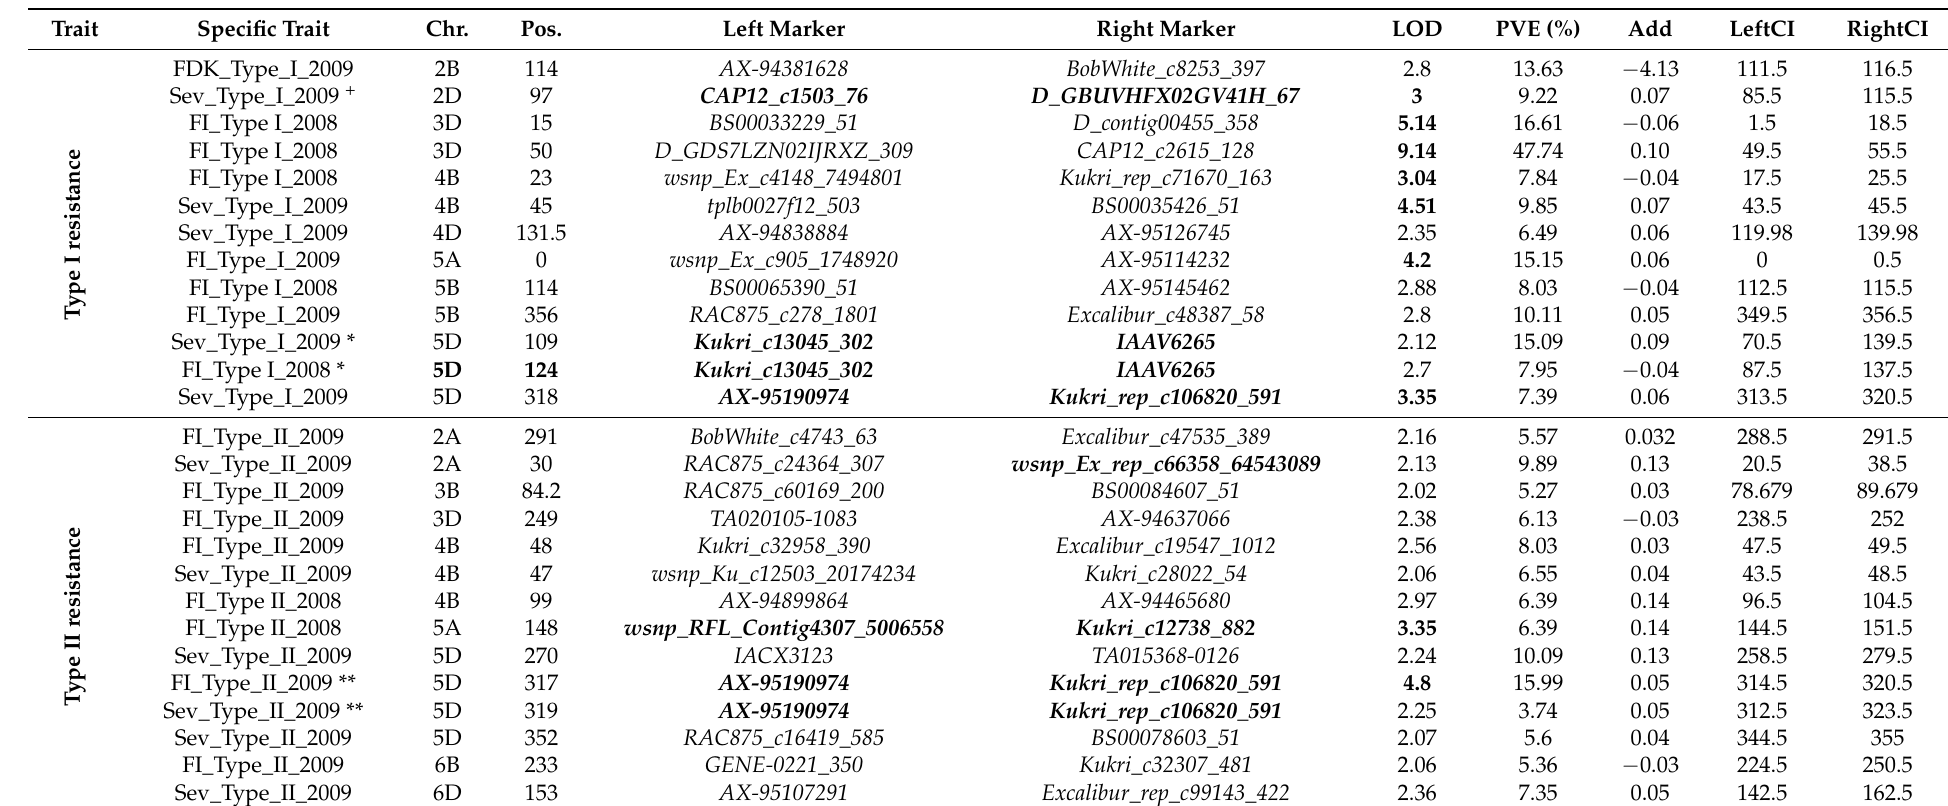
Table 2. Traits for Type I and II resistance against FHB that were significantly associated to marker loci, chromosome linked to, the additive effects, the level of significance and the variability explained, determined in ITMI/MP inoculated with F. graminearum. Severity: Sev_Type_I and Sev_Type_II; Fusarium index: FI_Type I and FI_Type II; thousand kernel weight in control (TKW_C) and for type I (TWG_Type I); Fusarium damaged kernel: FDK I; kernel weight per spike in control (KWS_C) and for Type I (KWS_Type I) and Type II (KWS_Type II). Markers involved in multiple QTLs are in bold. *, **, ***, + indicate same QTLs and loci. Positive sign in the Add column indicates that the positive effect is imparted by “Synthetic” parent and the negative sign indicates the positive effect being provided by